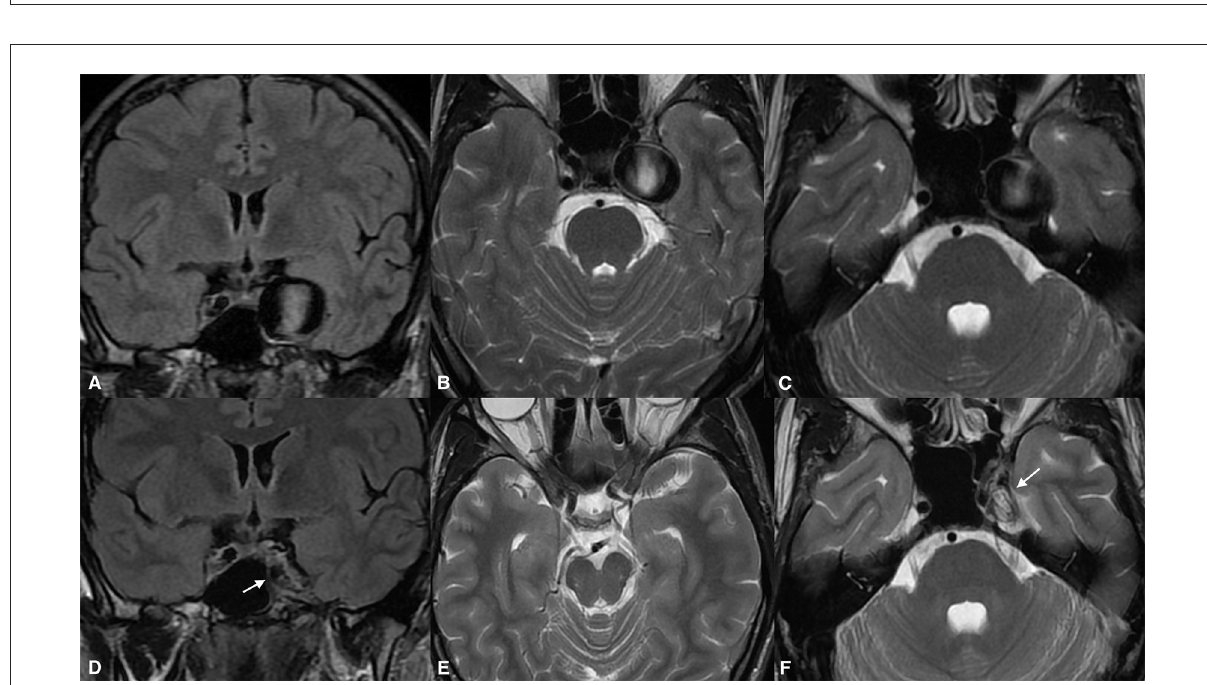
FIGURE3 Giant cavernous internal carotid artery aneurysm causing diplopia from oculomotor nerve involvement (A) . The same aneurysm was causing a slight mass effect over the left temporal lobe and the adjacent brain tissue (B,C) . Twenty-four months after the treatment, the magnetic resonance imaging [ (D) , arrow] demonstrated aneurysmal collapse (E) and elimination of the mass effect. Note the absolute shrinkage of the aneurysm with a volume reduction of up to 70% of its previous volume, as seen on the long-term follow-up [ (F) ,